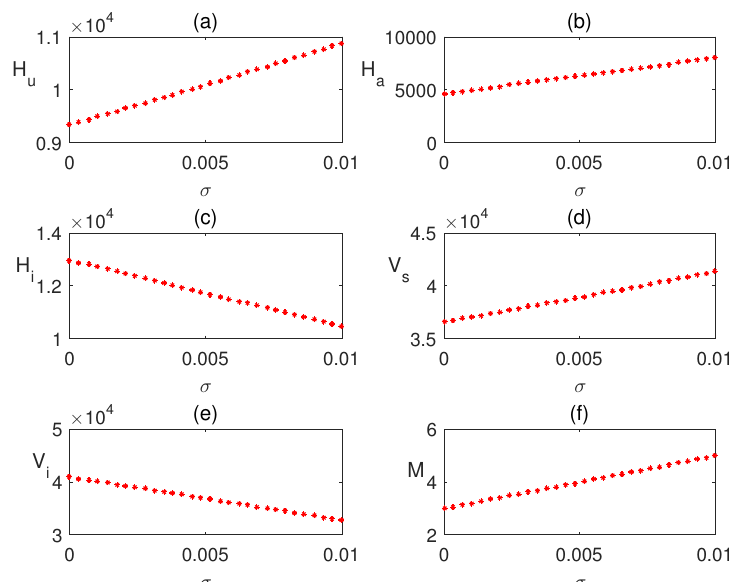
Figure 5. Effect of local awareness is shown varying the parameter σ .